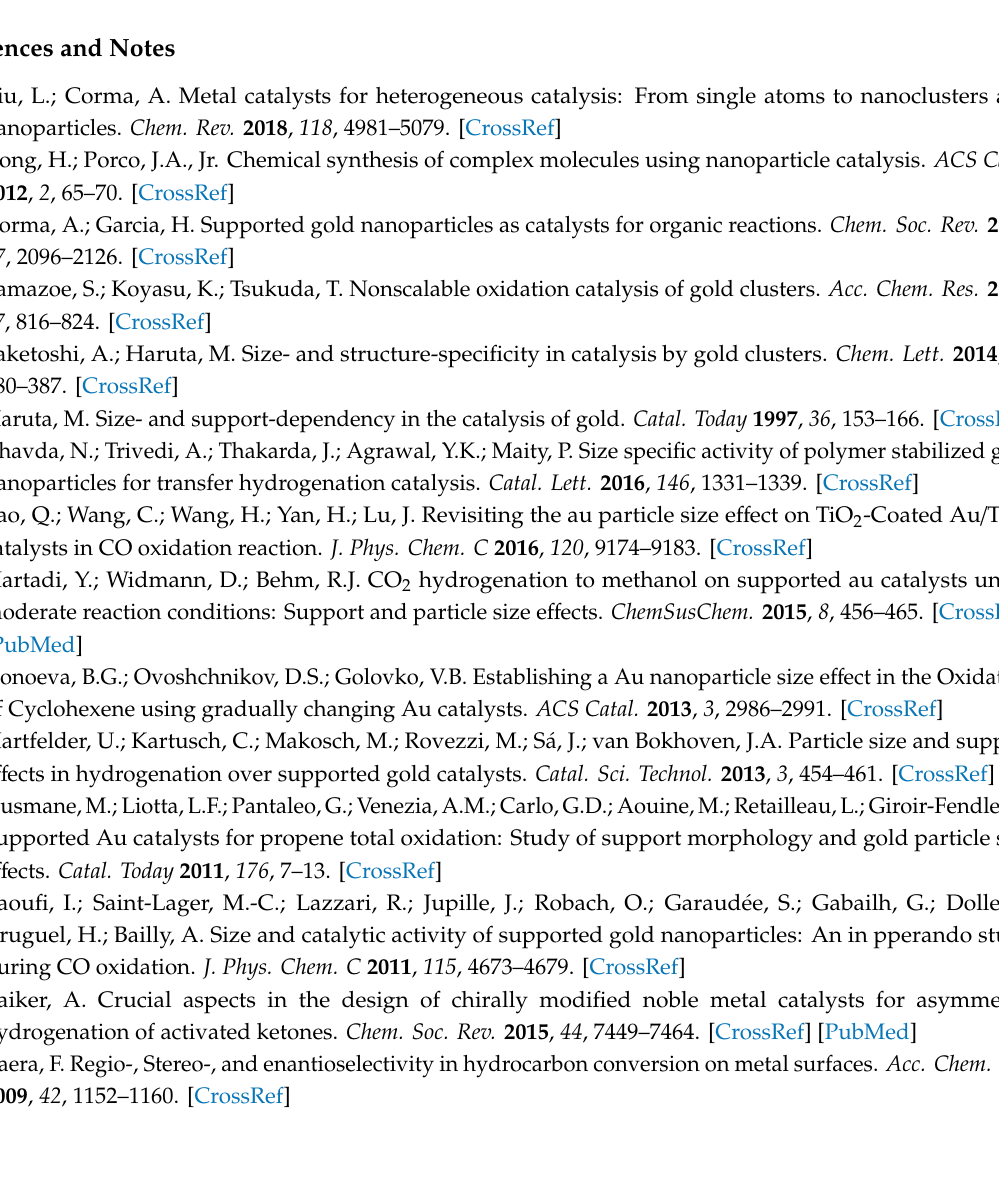
Figure S10: IR ATR spectra of dedocanethiolate SAM-coated AuNPs, Table S2: Catalytic reaction with sterically hindered thiolate-coated AuNP-arrays, Figure S11: SEM image of 10tDod-array, Figure S12: DFT-calculated vibrational bands of DMPS–OEt and proposed conformational change of the SAM, Figure S13: IR RA spectra of Dod-Au substrate in HexOH with